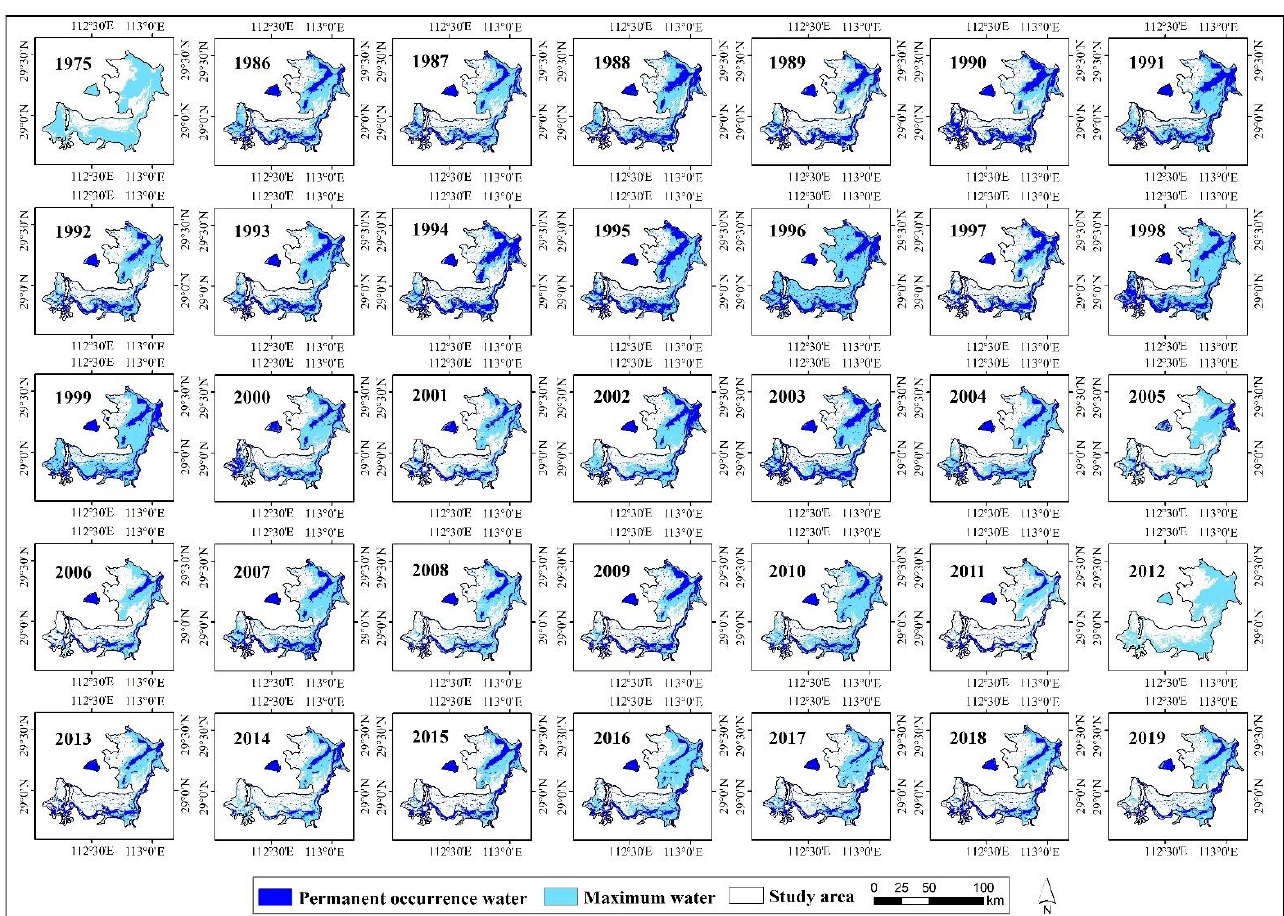
Figure 4. Annual maximum water and annual permanent occurrent water of Dongting Lake Figure 1975 to 2019.